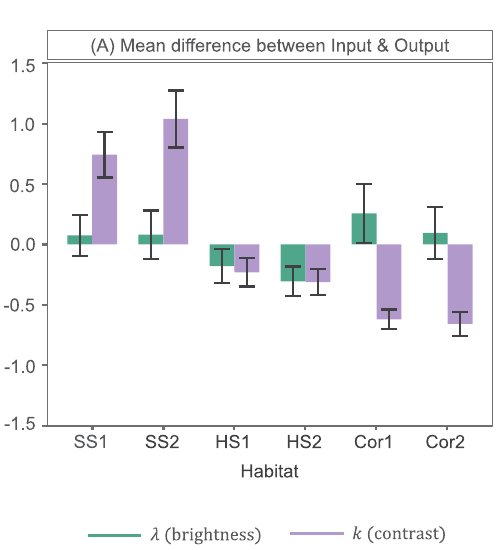
Figure A1. Mean standardized (Z − Score) difference in WTM parameters between all input and output WDs. Error bars represent 95% confidence